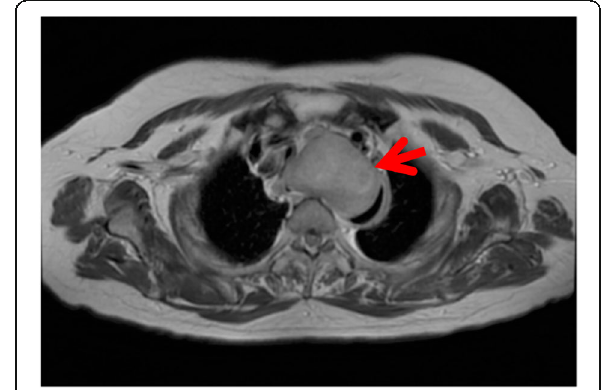
Fig. 2 T2WI magnetic resonance imaging revealed a heterogeneous inner